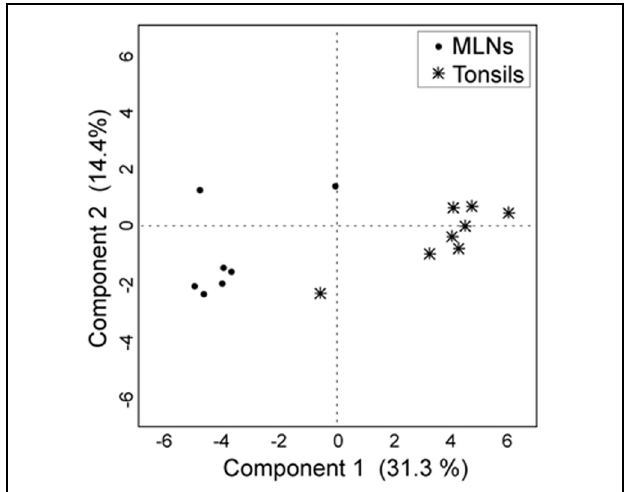
FIGURE 4 | Discriminant analysis with the first two principal components. For the discriminant analysis the 30 most abundant genera were used as covariates and the sampling site as the categorial variable. Each point corresponds to one sample.